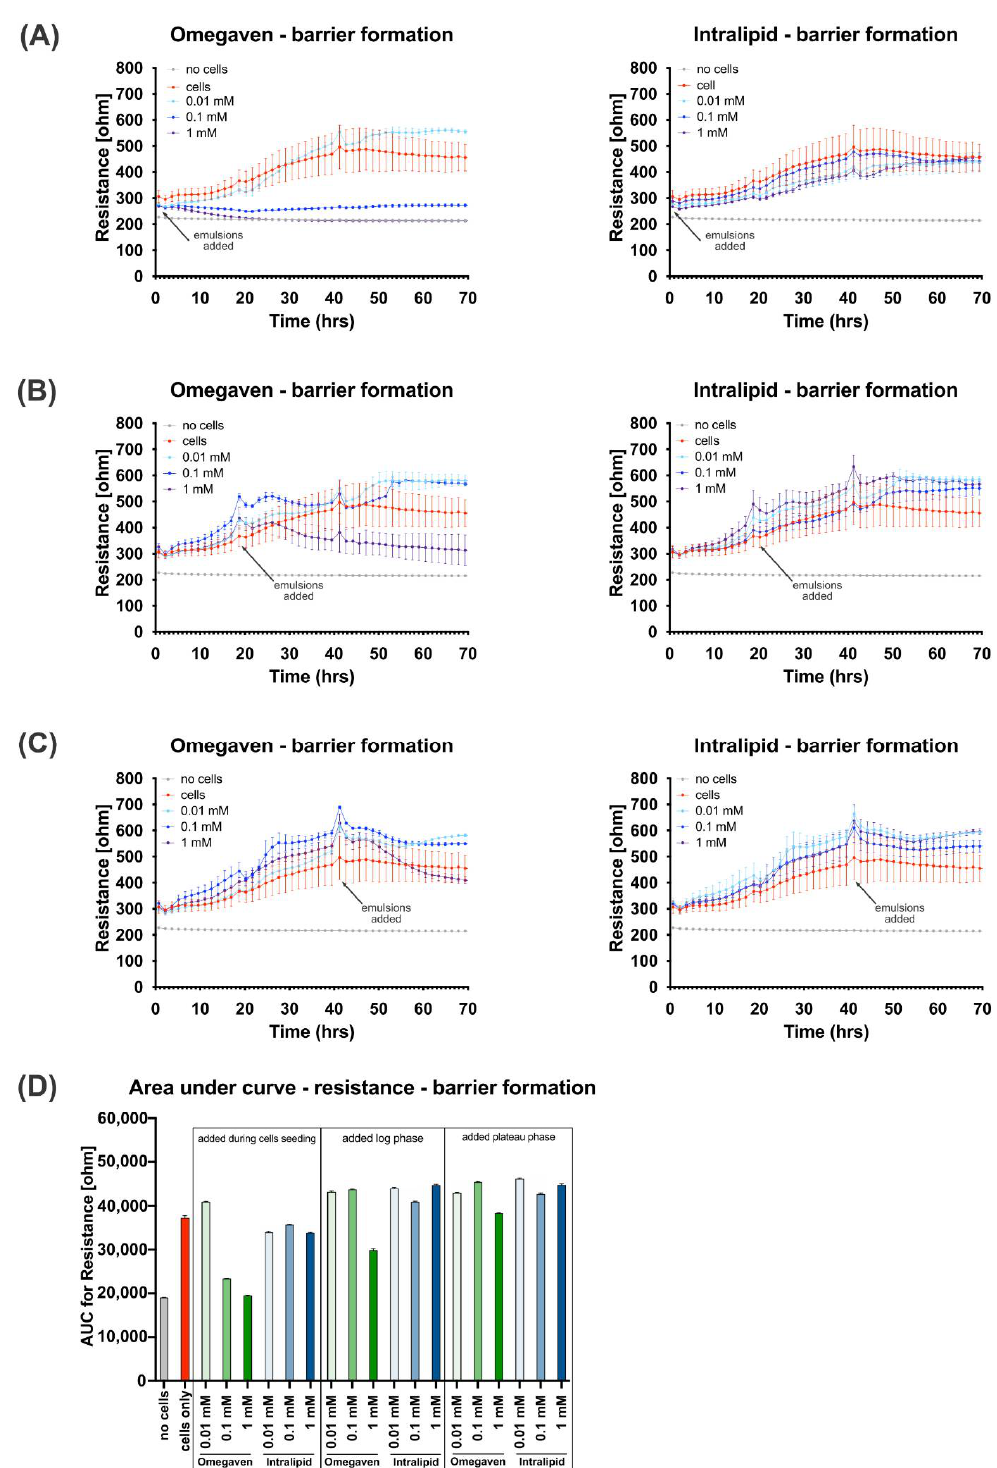
Figure 2. Omegaven ® reduces the barrier formation at high concentrations. Omegaven ® and Intralipid ® lipid emulsions at 0.01, 0.1 and 1 mM concentrations were added to endothelial cells during cell seeding on the ECIS electrode ( A ), during the logarithmic growth phase ( B ), and in cells of the plateau growth phase ( C ). The barrier formation was monitored by an ECIS ® Z θ (Z Theta) device, and 60 measurements of resistance (ohm) in 70 h were recorded for cells grown in triplicates. In addition, areas under the curve ( D ) for the graph presented in ( A – C ) were analyzed using (GraphPad, San Diego, CA, USA), X.Y. analysis/Area under curve